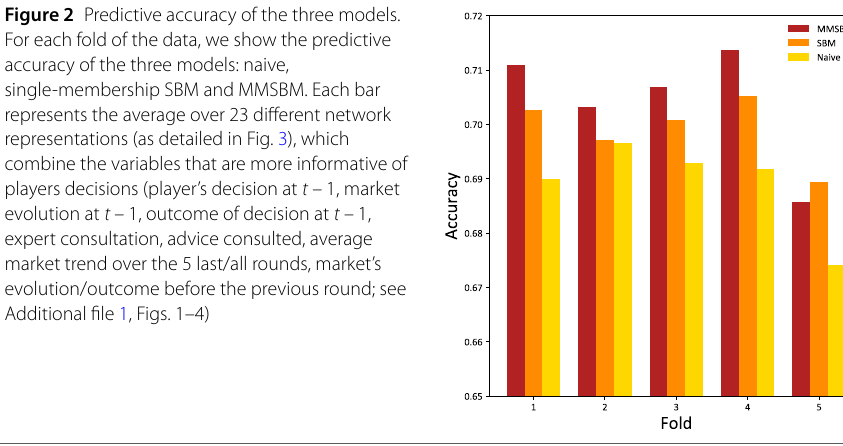
Figure 2 Predictive accuracy of the three models. For each fold of the data, we show the predictive accuracy of the three models: naive, single-membership SBM and MMSBM. Each bar represents the average over 23 different network representations (as detailed in Fig. 3), which combine the variables that are more informative of players decisions (player’s decision at t – 1, market evolution at t – 1, outcome of decision at t – 1, expert consultation, advice consulted, average market trend over the 5 last/all rounds, market’s evolution/outcome before the previous round; see Additional file 1, Figs.